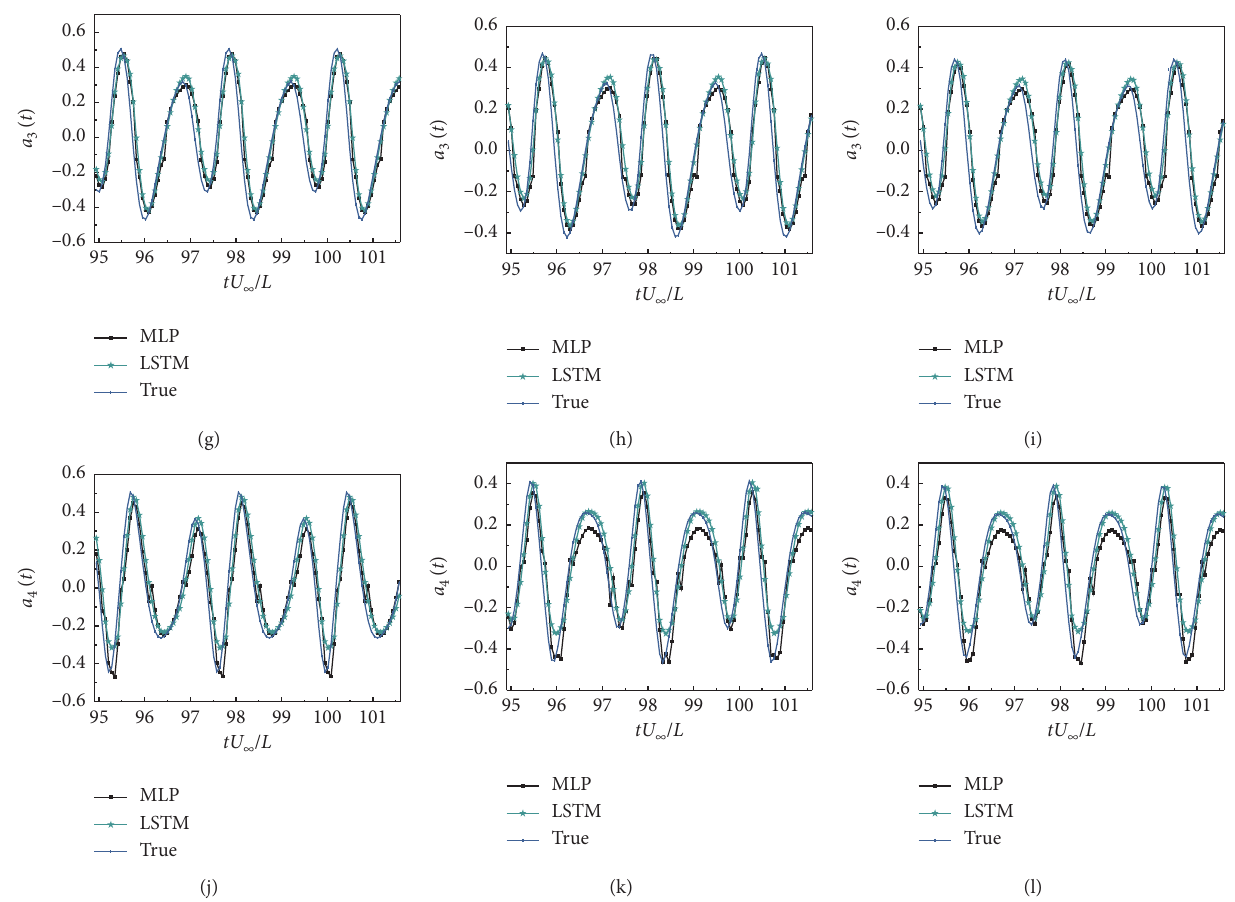
� 0.53. (b) a 1 ( t ) at Ma 1 ( t ) at